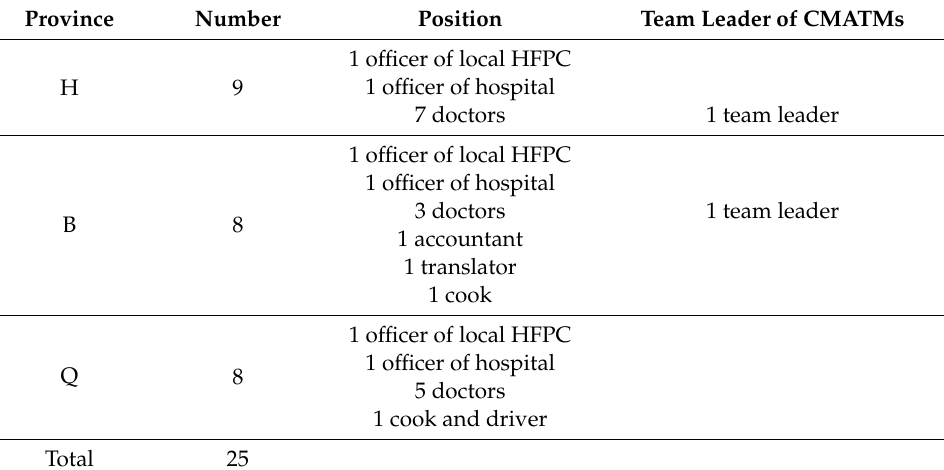
Table 1. Demographics of respondents ( n =